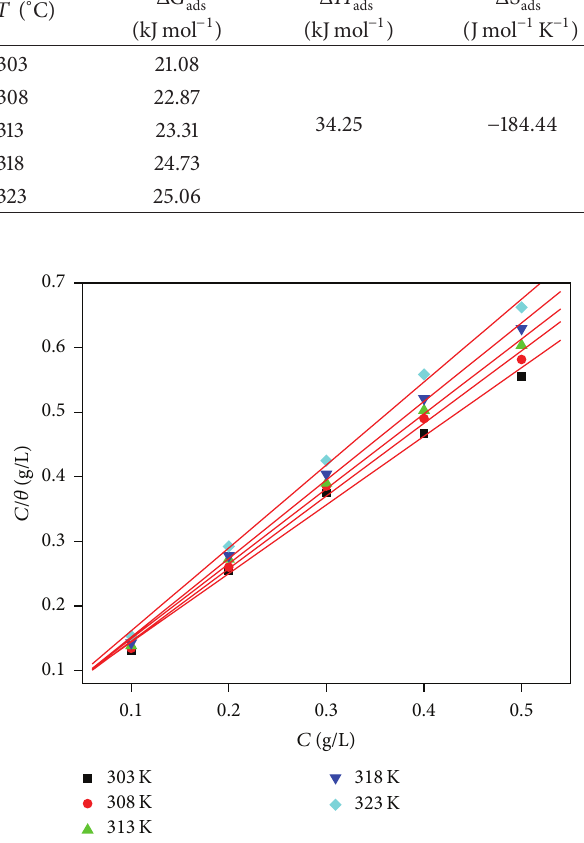
Figure 9: Langmuir adsorption isotherms for the adsorption of GIE on aluminum in 0.5M phosphoric acid solution at different